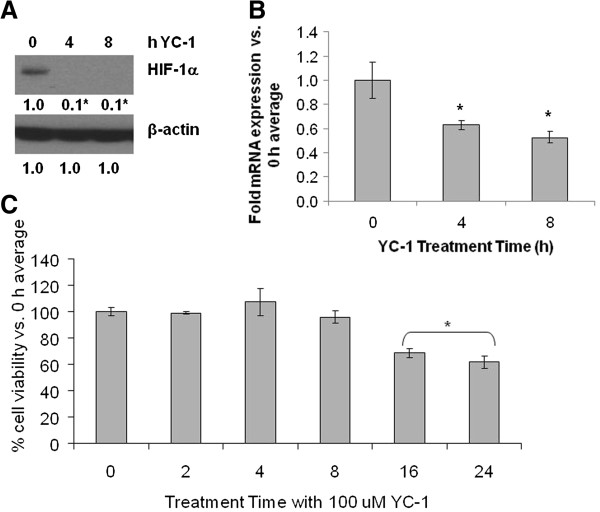
Effect of YC-1 on HIF-1α and BCRP expression and cell viability in LTLTCa cells. LTLTCa cells were treated with 100 μM YC-1 for 0 to 24 hours and effects on HIF-1α (A) and BCRP (B) expression and cell viability (C) were determined. A) After 0 to 4 hours of YC-1 treatment, total protein was extracted and HIF-1α and β-actin were analyzed by Western blot analysis. Shown are representative blots and overall densitometry results of n = 6 independent cell samples/group. Densitometry results are expressed as mean fold-change in protein levels compared to 0 hours after normalization to β-actin (mean ± SD of n = 6 independent cell samples/group; *versus 0 hours YC-1, P <0.001; overall P <0.0001, one-way ANOVA). B) After 0 to 8 hours YC-1 treatment, total RNA was extracted and BCRP mRNA and 18S rRNA were analyzed by real-time RT-PCR analysis. Real-time results are expressed as the mean fold-change in mRNA levels compared with vehicle after normalization to 18S rRNA (mean ± SD, n = 6 independent cell samples/group; *versus 0 hours YC-1, P <0.001; overall P <0.0001, one-way ANOVA). C) Viability of cells was measured by MTT assay after 0 to 24 hours treatment with YC-1. Results are expressed as mean percent of 0 hours average (mean ± SD, n = 4 independent cell samples/group; *versus 0 hours, P <0.001; overall P <0.0001, one-way ANOVA). ANOVA, analysis of variance; BCRP, breast cancer resistant protein; HIF-1α, hypoxia inducible factor 1 α subunit; MTT, 3-[4,5-dimethylthiazol-2-yl]-2,5 diphenyl tetrazolium bromide; n, number; SD, standard deviation.